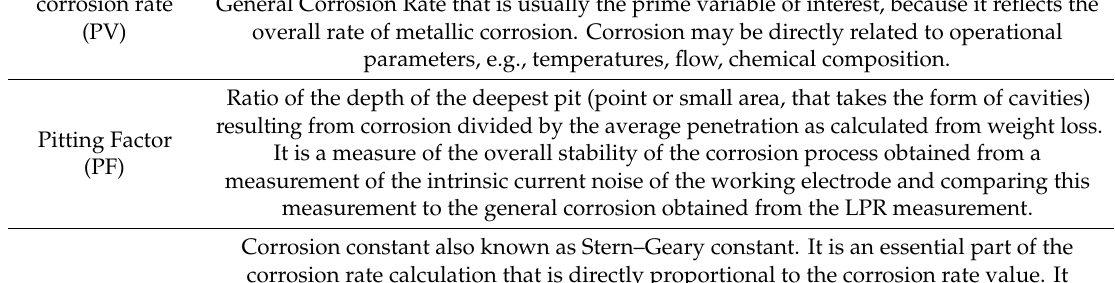
Table 1. Description of the recorded corrosion parameters.